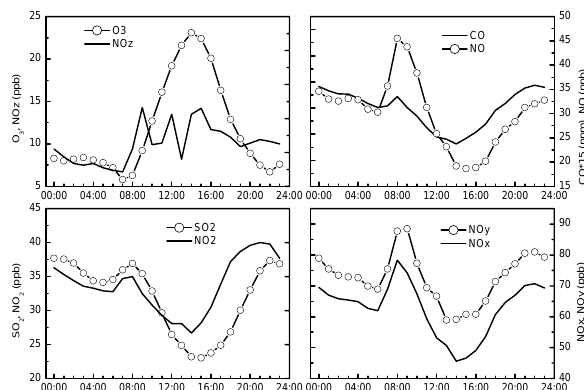
Fig. 5 The average diurnal variations of the concentrations of O 3 , NO/NO 2 /NO z /NO x /NO y , CO, and SO 2 at CMA in winter. Primary pollutants show similar diurnal patterns which indicate the dominant local emissions. During nighttime, O 3 is removed substantially by gas titration with high level of NO.